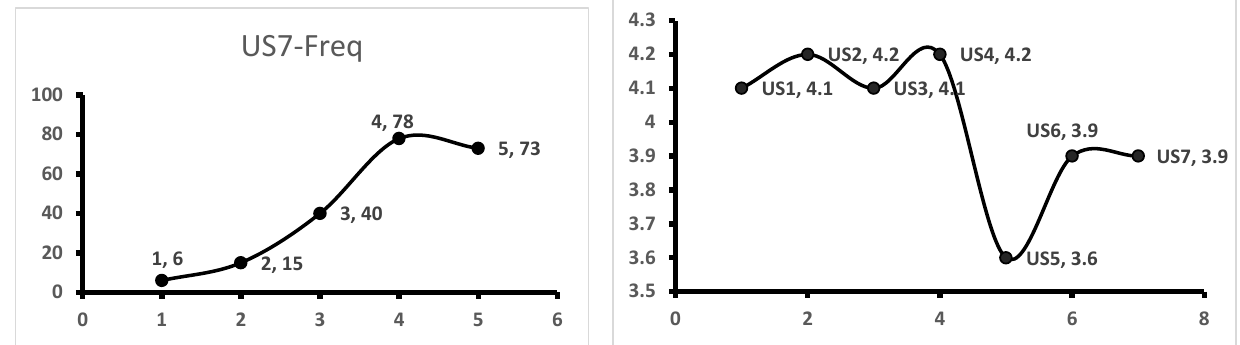
Fig. 8. Usability Quality Attributes indicators Figs. [1-7] . Usability attributes